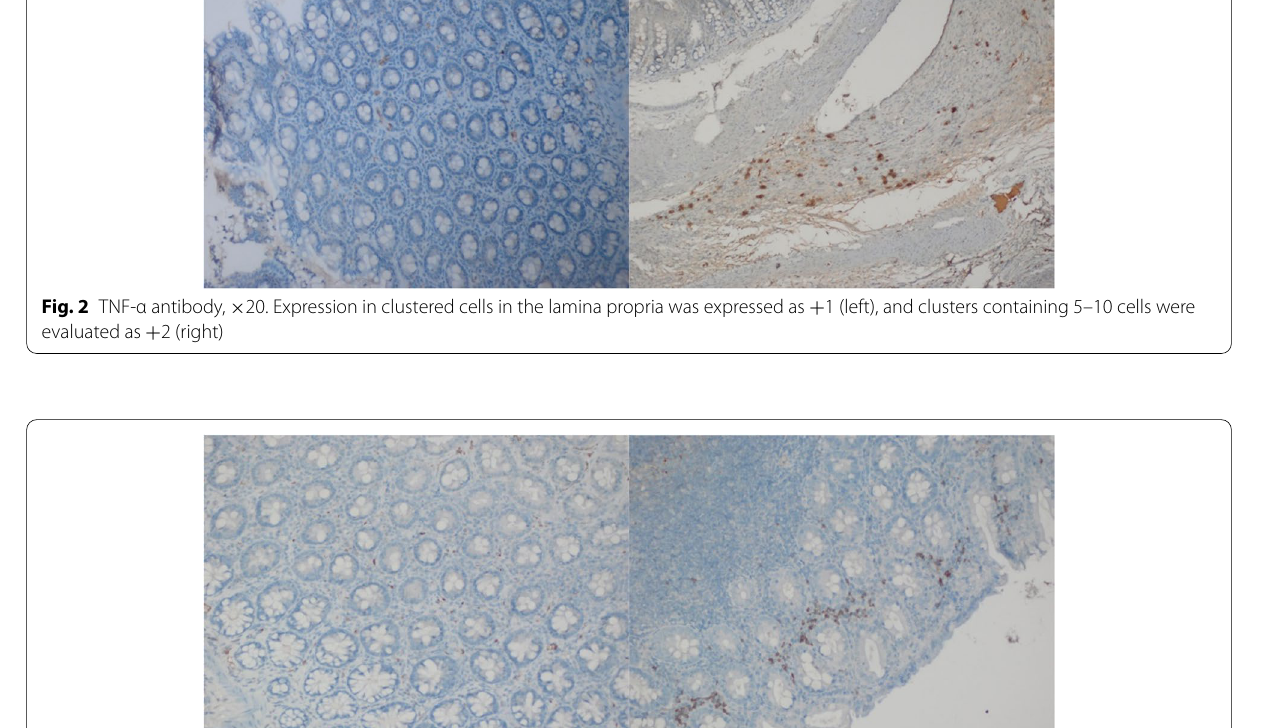
1 (left), and clusters containing 5–10 cells were +